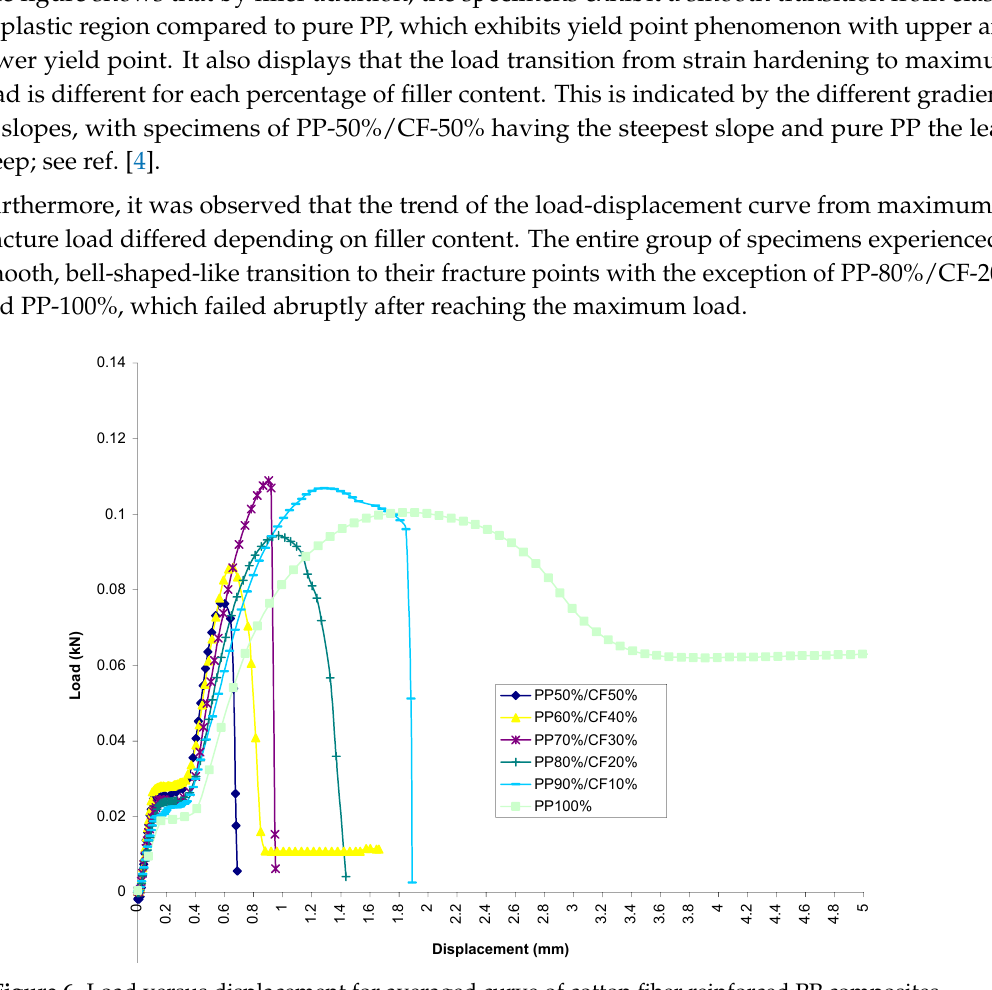
Figure 6. Load versus displacement for averaged curve of cotton fiber reinforced PP